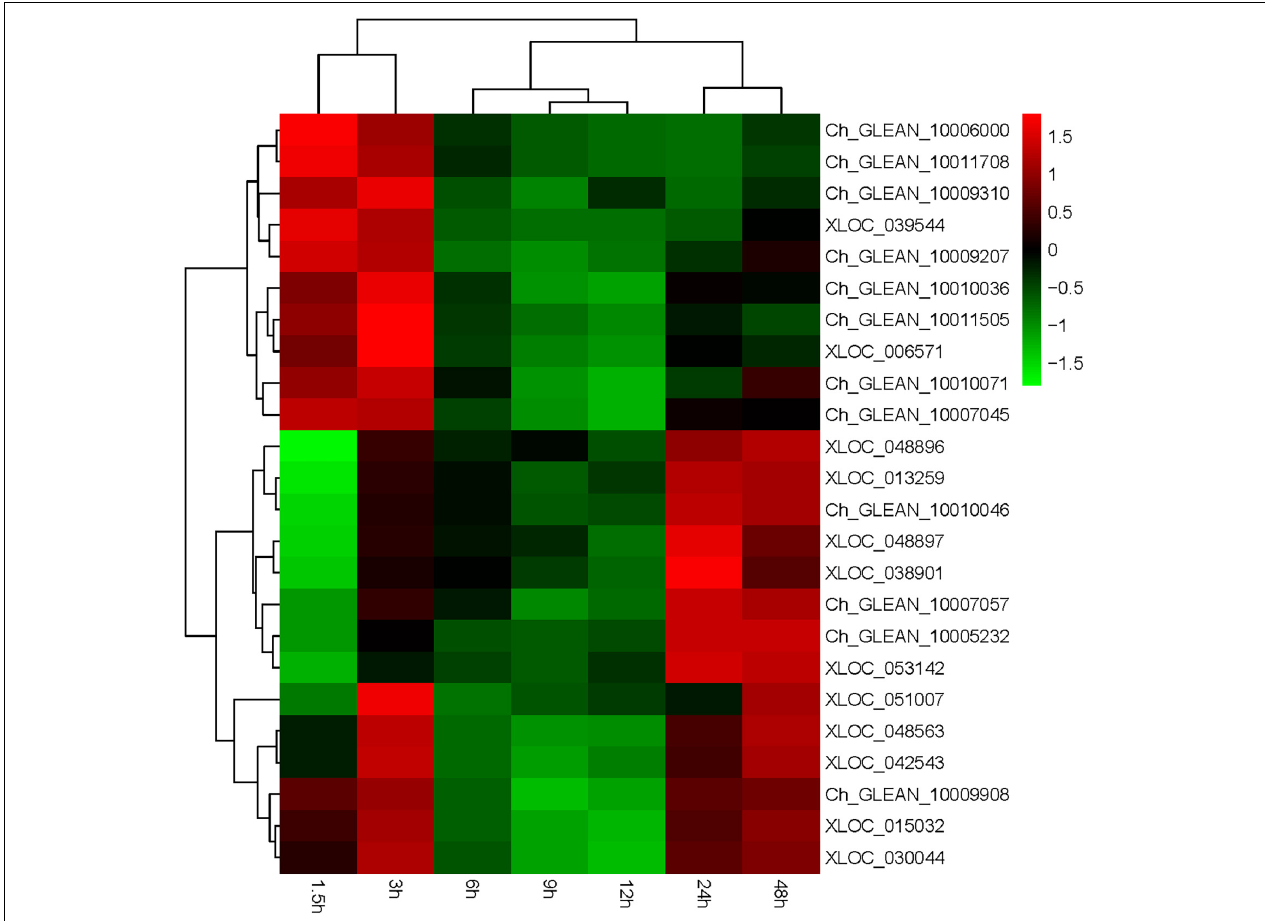
FIGURE 8 | Expression of astaxanthin synthesis-related genes from 0 to 48